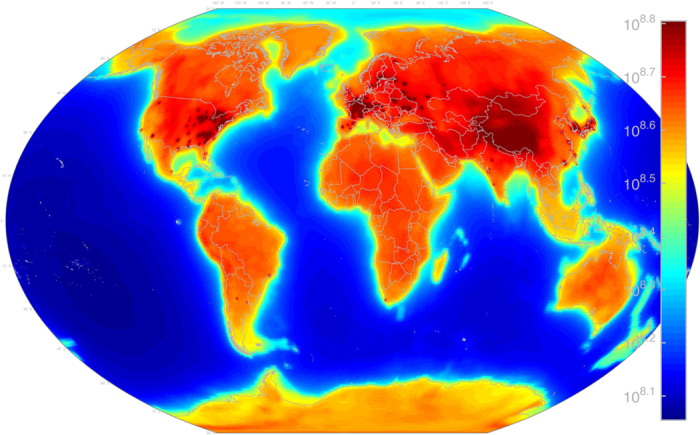
AGM2015: A wordlwide  flux map combining geoneutrinos from natural 238U and 232Th decay in the Earth’s crust and mantle as well as manmade reactor- emitted by power reactors worldwide.Flux units are  at the Earth’s surface. Map includes  of all energies. Figure created with MATLAB45.